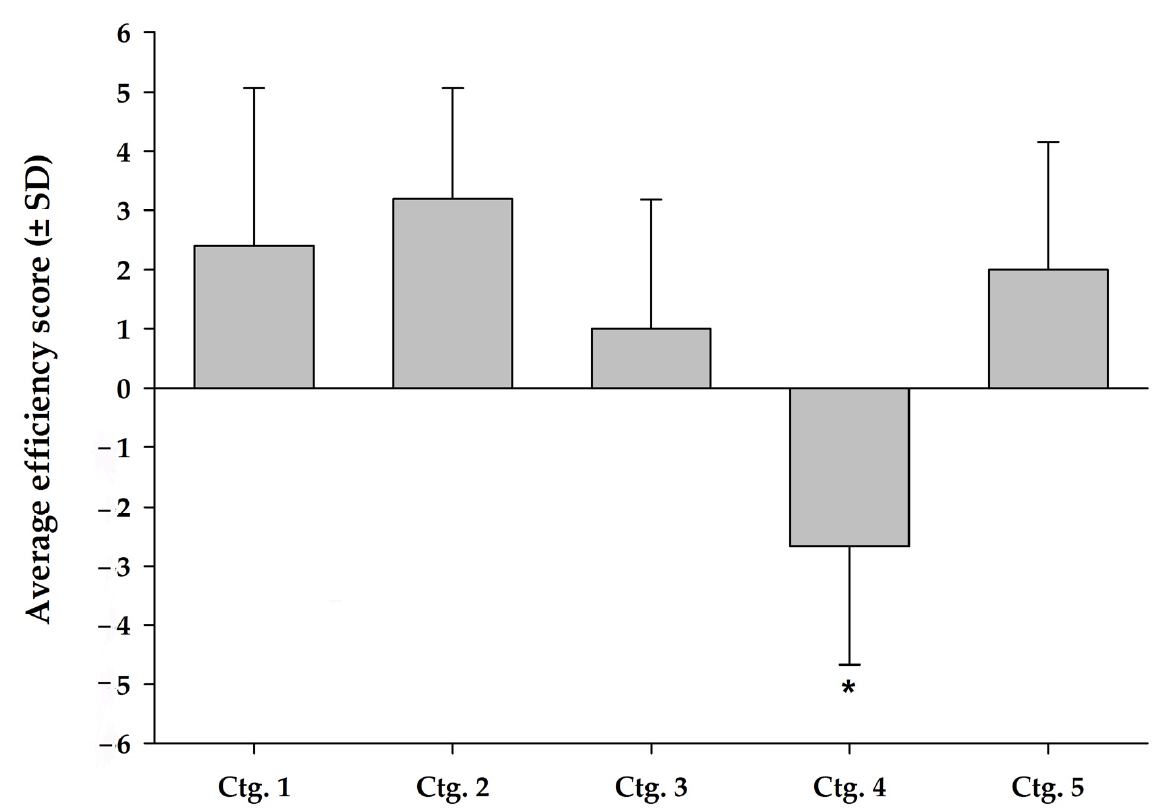
Figure 4. Average score (with standard deviation) of efficacy weighed for the quality level of categories 1 to 5. Weighted average efficacy score is plotted along with standard deviation of the score for each category. Ctg. 1 (omega-3-enriched therapeutic diets), ctg. 2 (omega-3-based nutraceuticals), ctg. 3 (collagen-based nutraceuticals), ctg. 4 (chondroitin-glucosamine-based nutraceuticals) and ctg. 5 (cannabinoid-based nutraceuticals). Ctg., category. * indicates significant difference ( p <